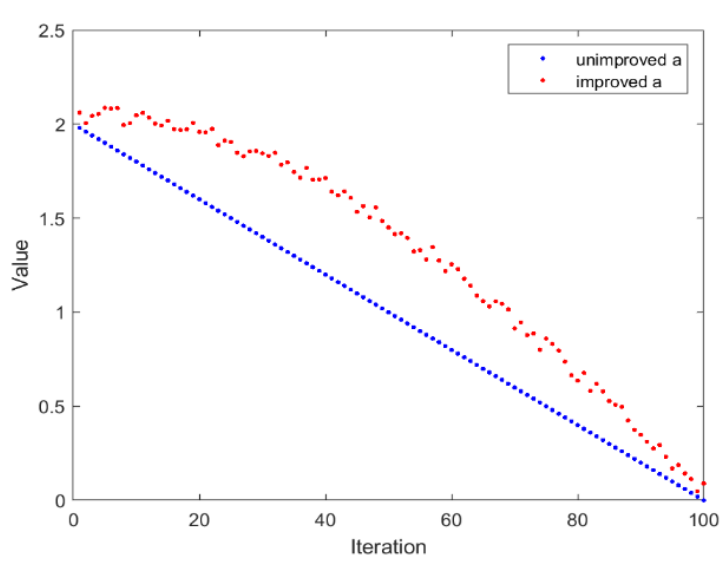
Figure 3. The variation in convergence factor with the number of iterations.